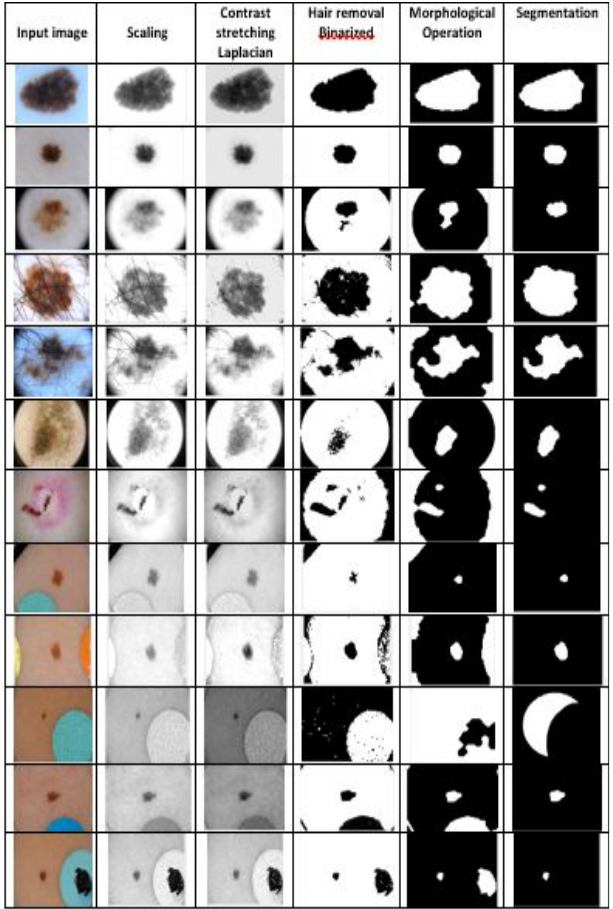
Figure 14. Implementation Results applying on different type of